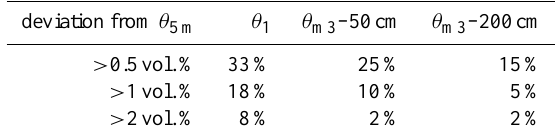
Table 4. Deviation between median measured water content in 5m cross-sections θ 5m : if one measurement is done θ 1 and to median water content if three measurements are done θ m3 at regular hori- zontal spacings of 50–200cm.